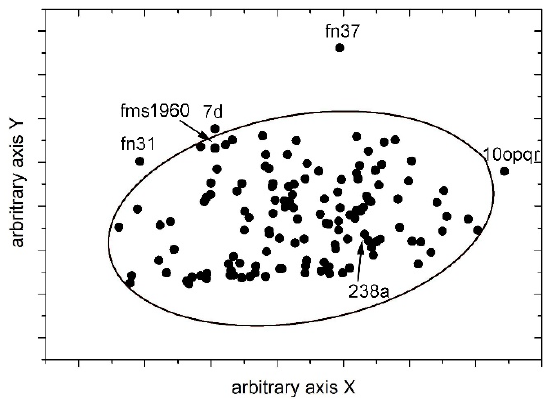
Figure 8. Averaged RGB CL colors projected on the median plane for of all the analyzed samples; a general 95% confidence ellipse has been drawn on it. Some samples have been labeled to identify their positions.